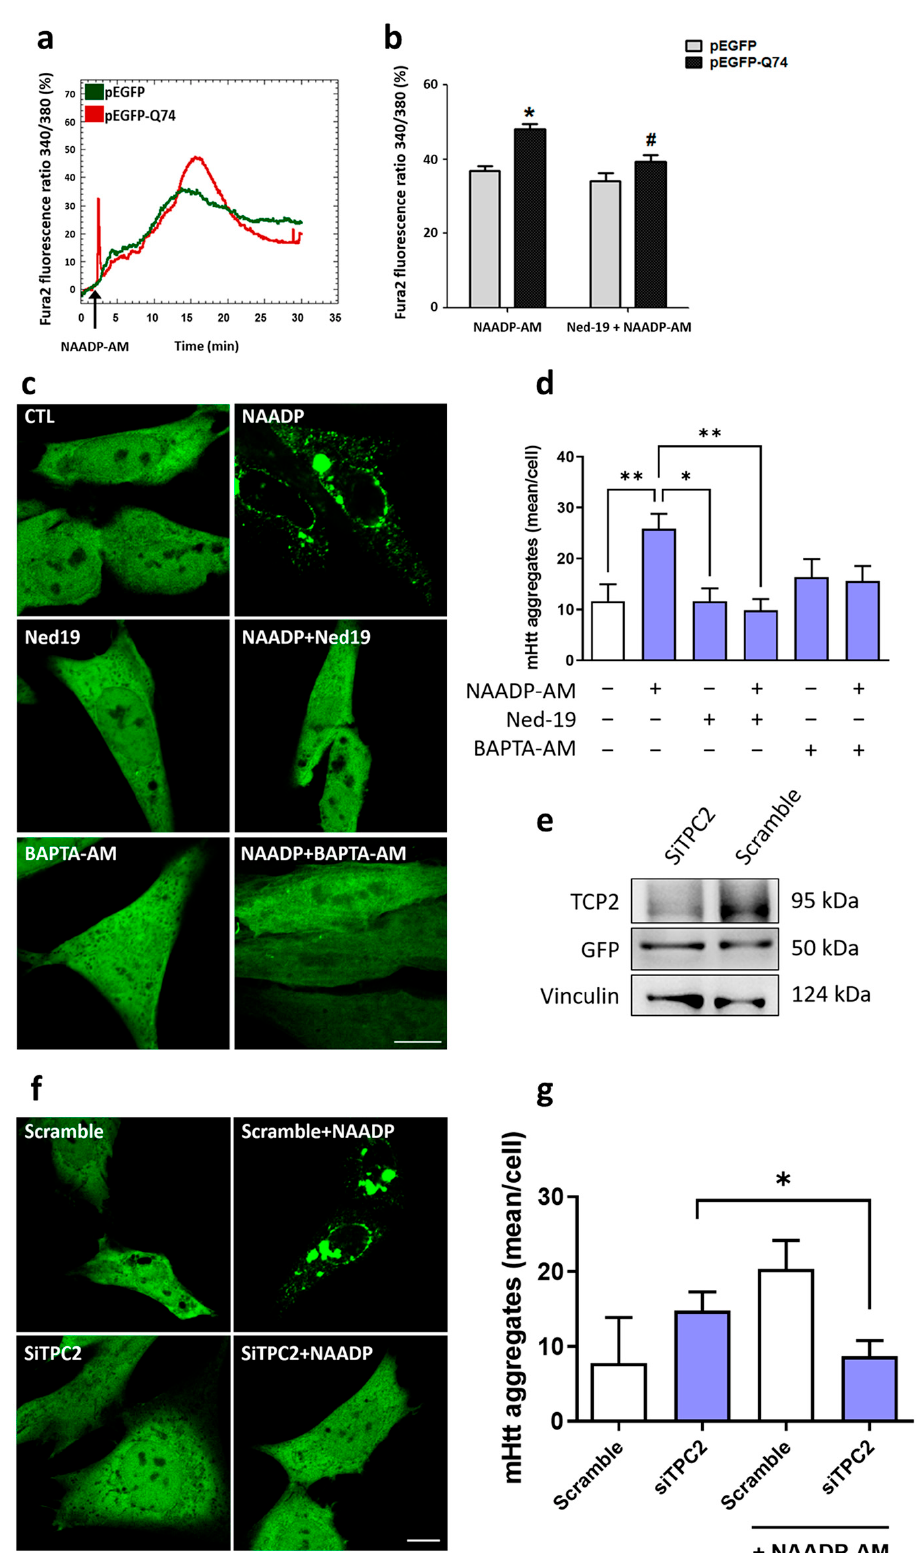
Figure 1. NAADP mediates Ca 2+ mobilization and mHtt-Q74 aggregation in astrocytes. Astrocytes were transiently transfected with the pEGFP-mHtt-Q74 vector or pEGFP-empty vector, followed by evaluation of Ca 2+ mobilization and mHtt-Q74 aggregation. Additionally, mHtt-Q74 aggregation was analyzed